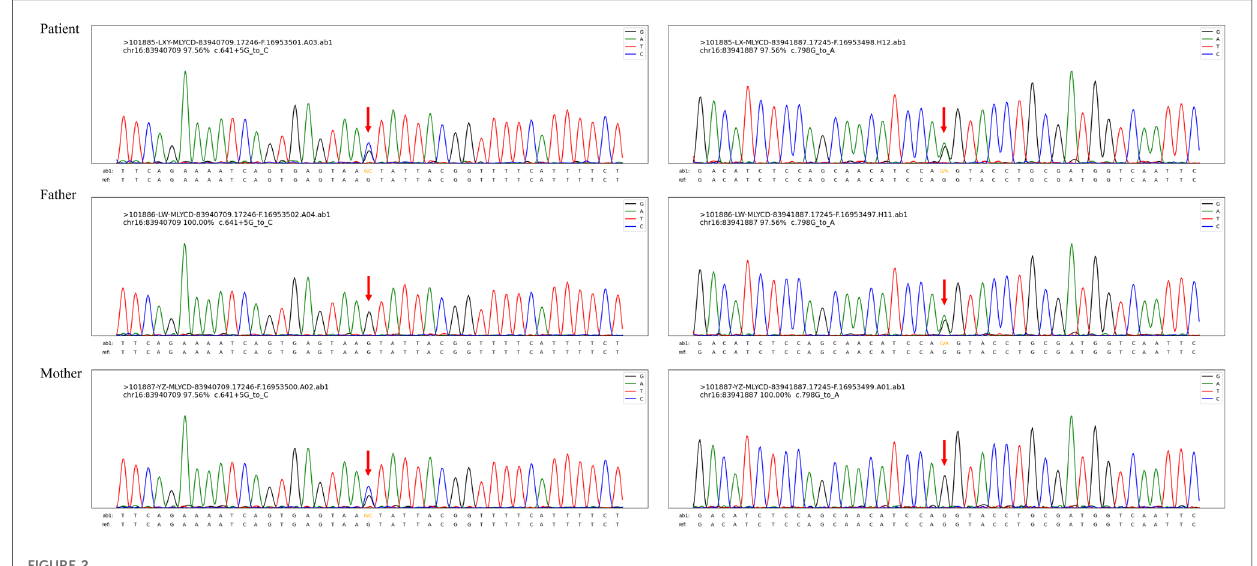
FIGURE 2 Dot variation correlation map of the MLYCD gene in the case